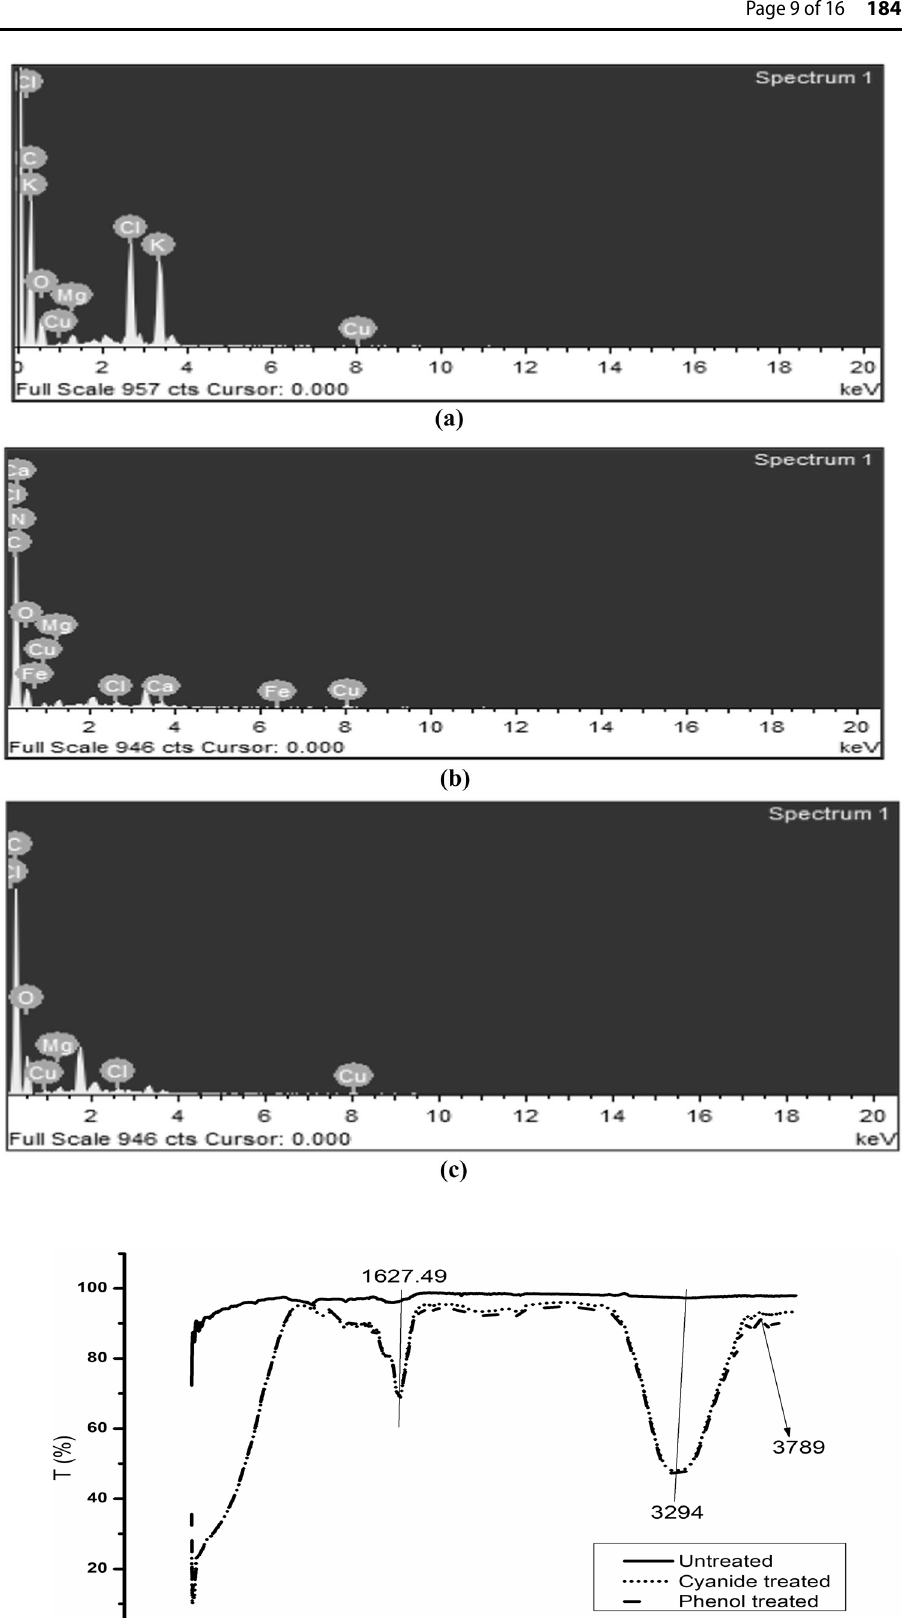
Fig. 4 a EDAX for CIABT before adsorption. b EDAX for CIABT after adsorption of cyanide. c EDAX for CIABT after adsorption of phenol